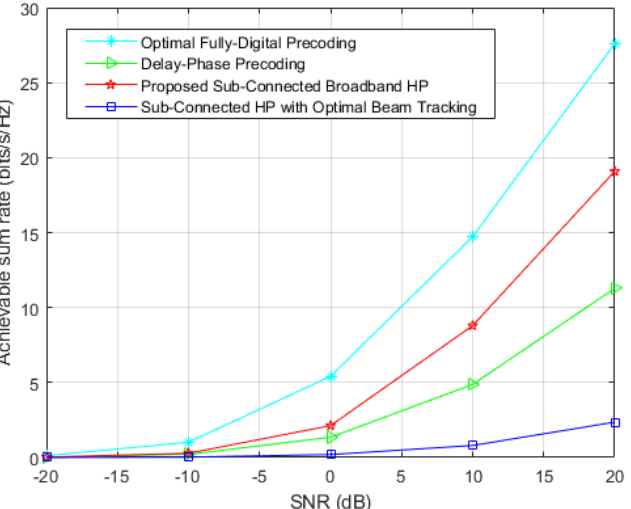
Figure 5. Comparison of achievable sum-rate of different precoding under high bandwidth-frequency ratio ( B = 30